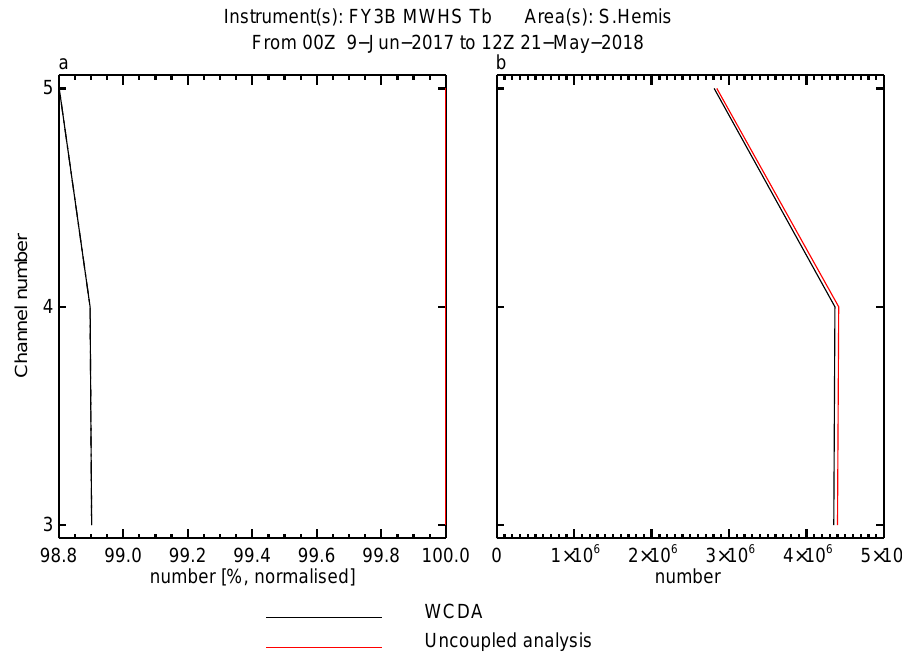
Figure 10. Observation usage of MWHS-1 in the southern hemisphere for the WCDA experiment (black) and the uncoupled control (red). Figure ( a ) shows the normalised observation usage and figure ( b ) shows the absolute numbers.